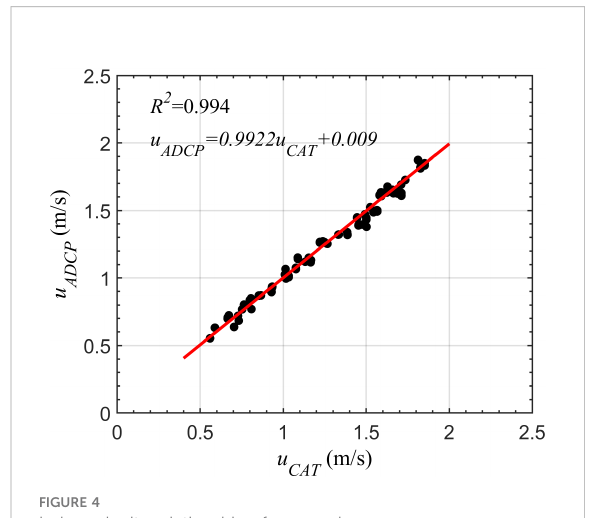
from precipitation, varied from 0 to 34,822 m 3 /s with a mean of